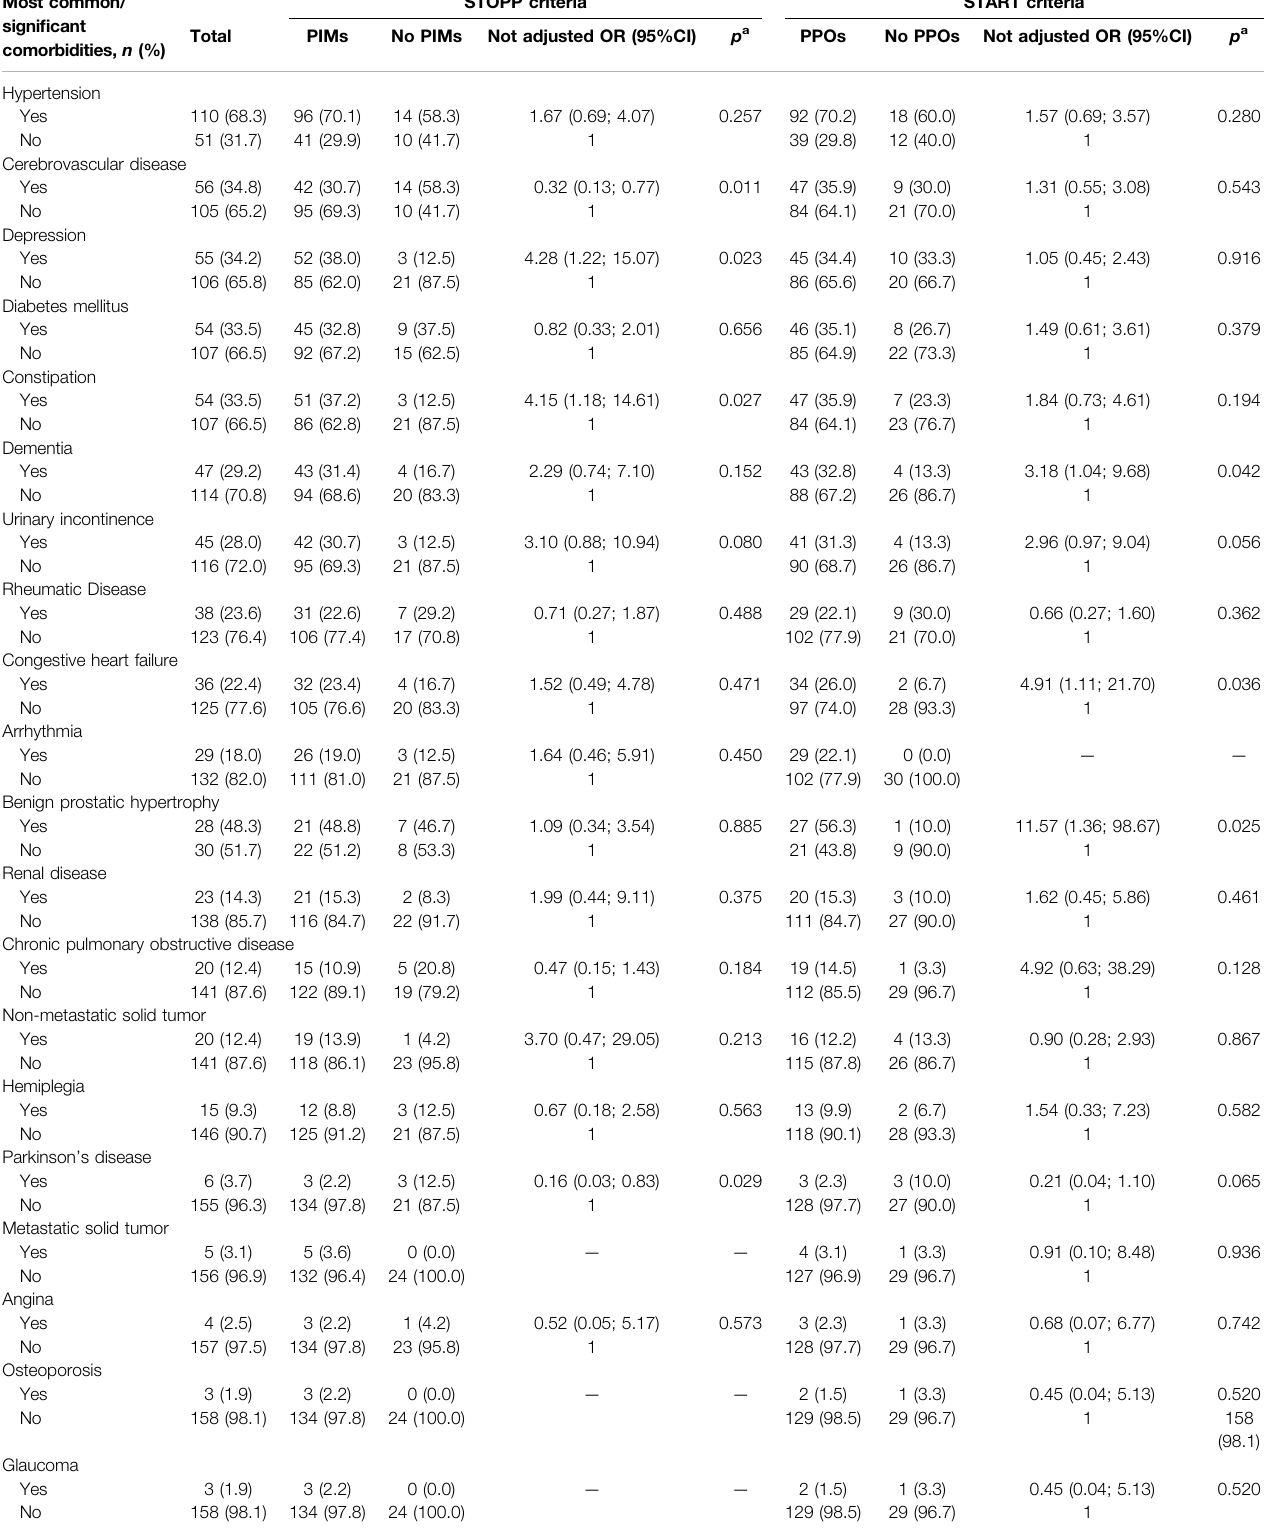
TABLE 3 | Mostcommon/signi fi cantcomorbiditiesofstudypopulation( N (cid:1) 161)thatreceivedpost-acutecareandlong-termcareinUnitsforIntegratedContinuousCare( Unidades de Cuidados Continuados , UCCI) inserted in the Portuguese National Network for Long-term Integrated Care ( Rede Nacional de Cuidados Continuados Integrados , RNCCI). Most common/ STOPP criteria START signi fi cant comorbidities, n (%)